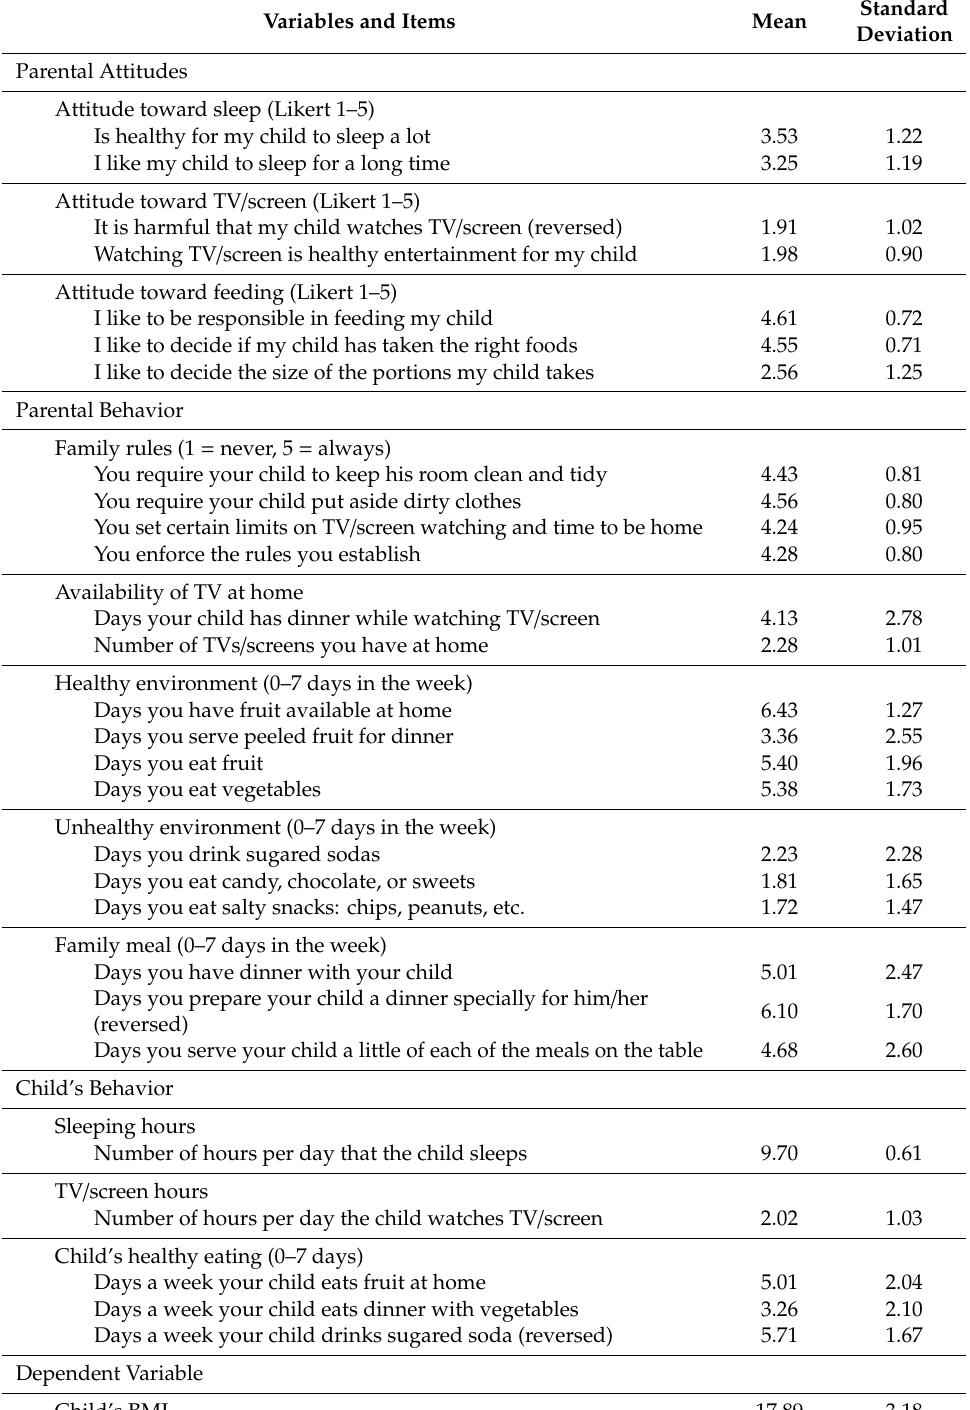
Table 1. Means and standard